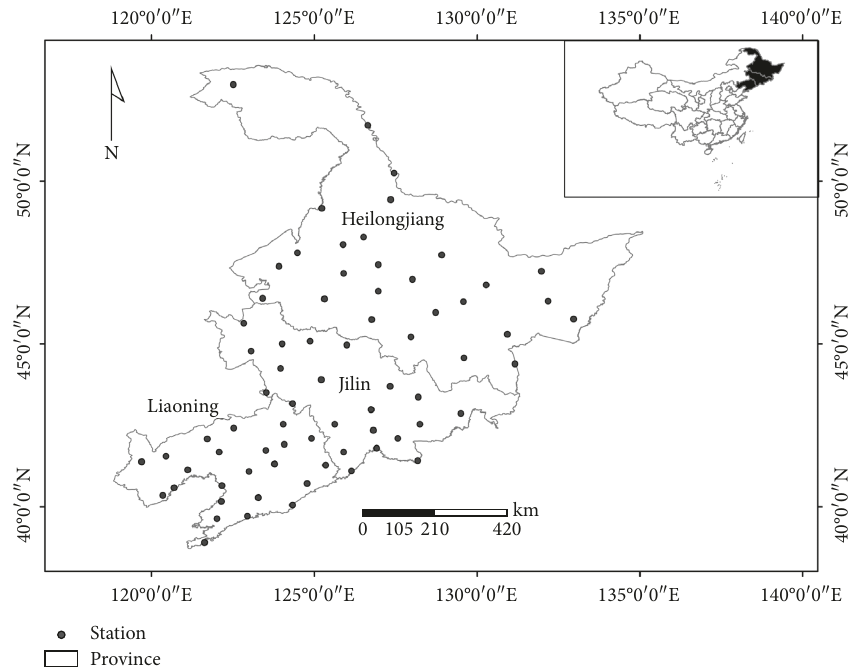
Figure 1: Distribution of its meteorological stations in Northeast